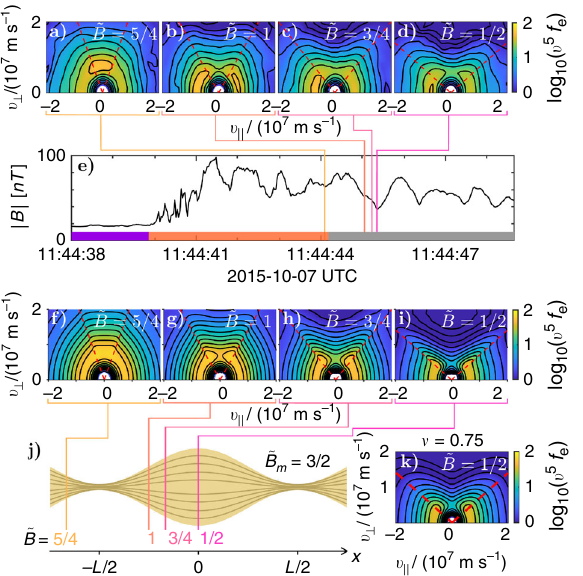
Fig. 3 Comparison of MMS observations with model. a – d Electron distributions recorded by the Fast Plasma Investigation (FPI) instruments on MMS3 at 30 ms resolution for the rippled foreshock event reported in ref. 27 , for the estimated points along the fl uctuation where ~ B 2 f 5 = 4 ; 1 ; 3 = 4 ; 1 = 2 g . The distributions are weighted by the factor v 5 to visually Fig. 4 Comparison of f e ( v ) evolution. a The energization G as a function of enhance the anisotropic features. The trapped-passing boundary is denoted the amplitude of a fl uctuation, δ B / B 0 , and the scattering frequency, ν , for the by a red dashed line. e Magnetic- fi eld strength along the foreshock numerically-computed Lorentz (solid) and Krook (dashed) operators, as well encounter, where the colored lines denote the times where the distributions as the analytical solution. b Combined estimate of the evolution of the in a – d were taken. The purple bar on the bottom denotes the part of the distribution function from magnetic pumping and compressional heating for observation that is in the solar wind, followed by an orange bar that denotes the points denoted in colored lines in Fig. 2a, obtained by integrating Eqs. (1) the foreshock and bow shock, then a gray bar for the part of the observation and (6) for T = 15×2 π / ω , with δ B / B 0 = 0.7, and ν /( ω /2 π ) = 0.75. c that is in the magnetosheath. f – i Expected distribution functions computed Reproduction of Fig. 2e. The green dashed line denotes what the fi nal using Eq. (3) integrated at ð δ B = B 0 Þ sin ð ω t 0 Þ ¼ 0 : 5. The distributions are distribution would look like if it only underwent compressional heating. Using evaluated at the same ~ B inferred from the MMS data in a – d . In this = T = T these conservative parameters, ð T 0 : 83 ð T , comparison we have assumed the Taylor hypothesis 35 , that the changes in Obs Exp Þ Theory ¼ Obs Exp Þ MMS where most of this difference stems from the discrepancy in low energy B recorded by the spacecraft are mainly caused by the spatial, not temporal, particles. variations. For all electron distributions, the red dashed lines indicate the = v 2 trapped/passing boundaries, characterized by v 2 ¼ ð B 0 þ δ B Þ = ? k B ð t ; x Þ (cid:2) 1. Electrons with ( v ∥ , v ⊥ ) in the vicinity of these boundaries follow 0 average of ∂ E = ∂ t ¼ μ ð ∂ B = ∂ t Þ to be positive. This explains the